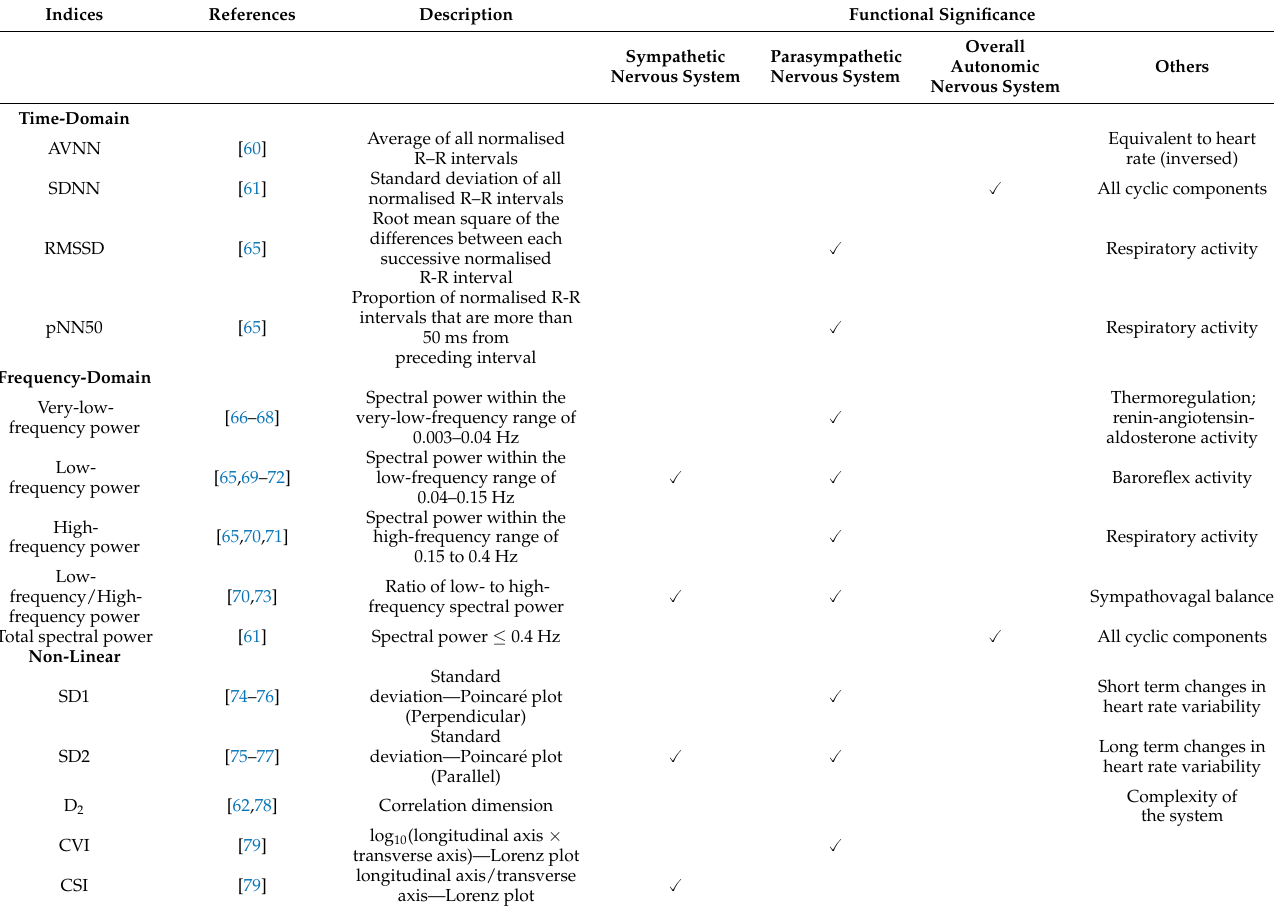
Table 2. Major Heart Rate Variability